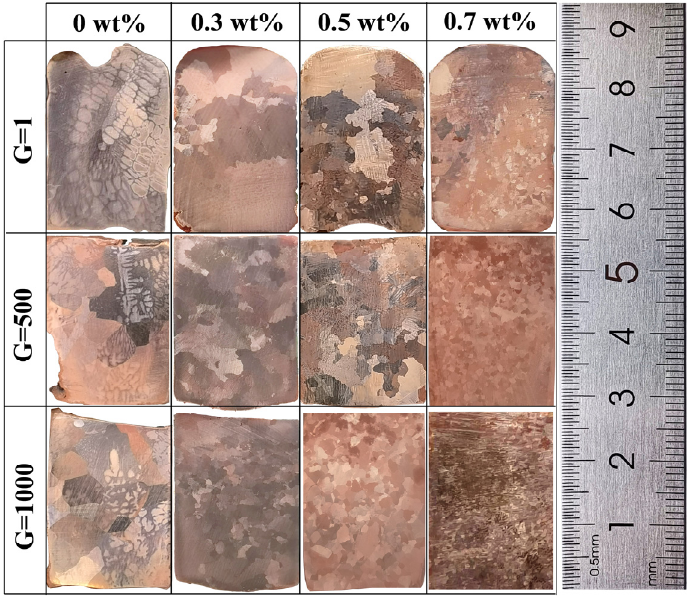
Figure 3. Effect of different Sn contents on the grain size of Cu alloy under different gravity coefficients.